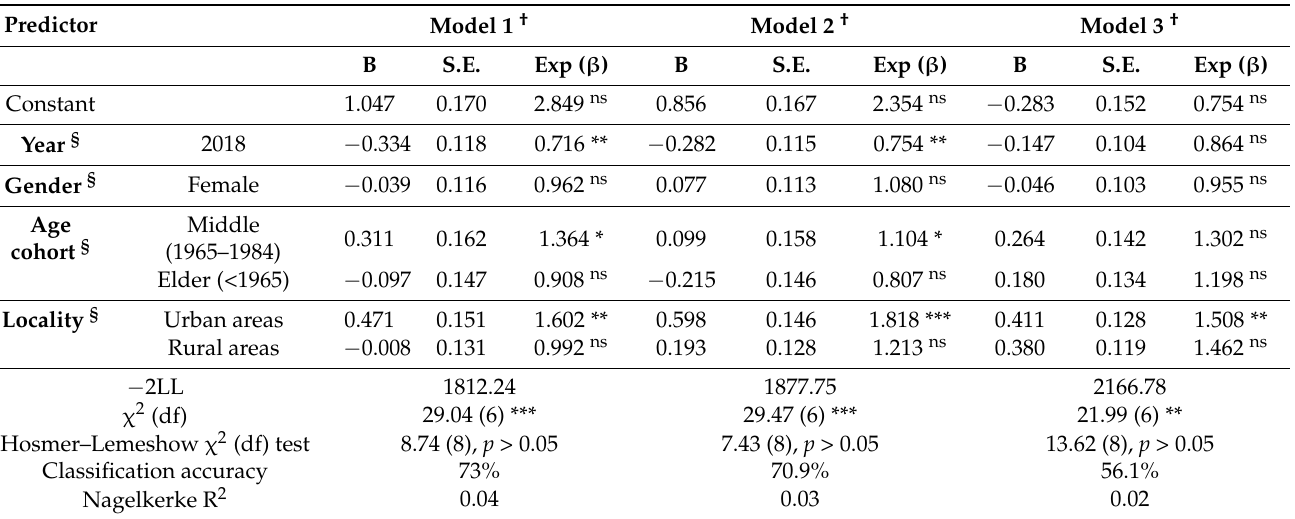
Table 6. Anti-clergy sentiments by gender, age cohort, locality, and year among Roman Catholic population in Lithuania (N =